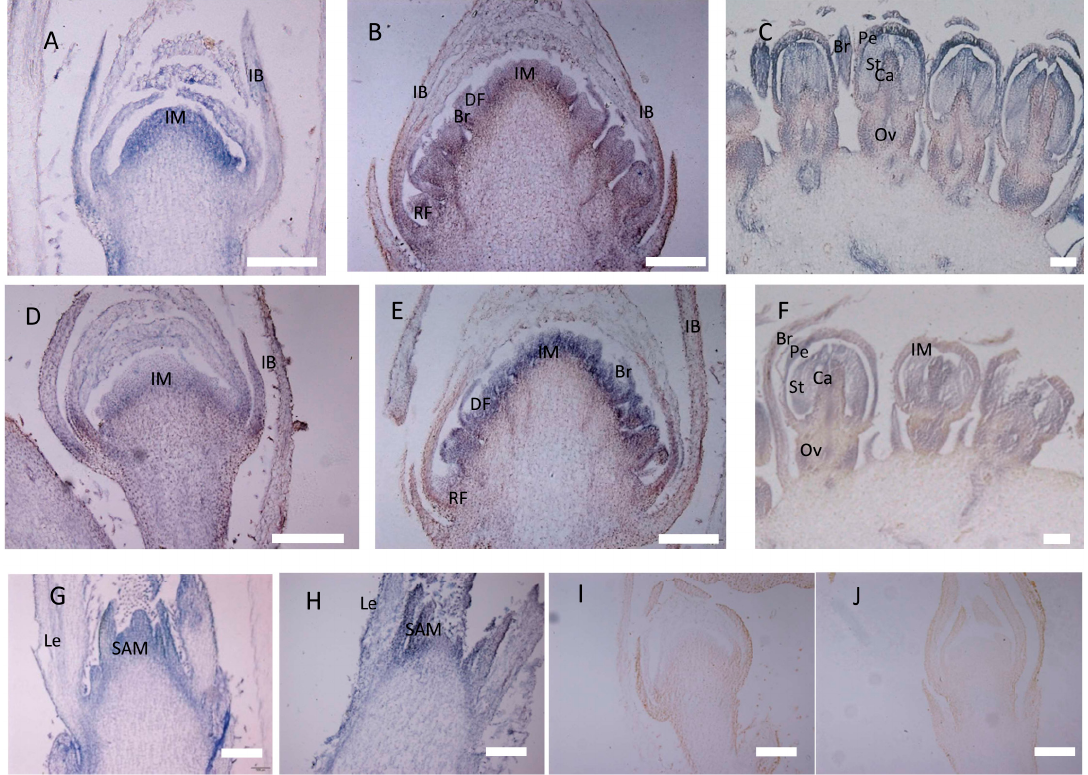
Figure 7. In situ hybridization of CbLFY and CbUFO in wile-type cosmos. ( A ) Expression of CbLFY was detected in the young dome-shaped IM and IB; ( B ) expression of CbLFY was detected in developed inflorescence meristem in transition to floral meristem, disc flower meristem, and young bract; ( C ) expression of CbLFY was detected in the young bract, petal, stamen, carpel, and ovary; ( D ) expression of CbUFO was detected in the young IM, but did not reach the surface and was absent from IB; ( E ) expression of CbUFO was detected in developed inflorescence meristem in transition to floral meristem, disc flower meristem, and young bract, but was absent in the ray floral meristem; ( F ) expression of CbLFY was detected in young petal, stamen, carpel, and ovary; ( G ) expression of CbLFY was detected in the vegetative shoot apical meristem (SAM), but was absent from the leaf; ( H ) expression of CbUFO was detected in the vegetative shoot apical meristem (SAM) and the leaf; ( I ) sense probe for CbLFY ; ( J ) sense probe for CbUFO . SAM, shoot apical meristem; Le, leaf primordium; IM, inflorescence meristem; IB, involucral bract; DF, disc flower meristem; RF, ray flower meristem; Br, bract; Pe, petal; St, stamen primordium; Ca, carpel; Ov, ovary. Scale bars = 200 um.